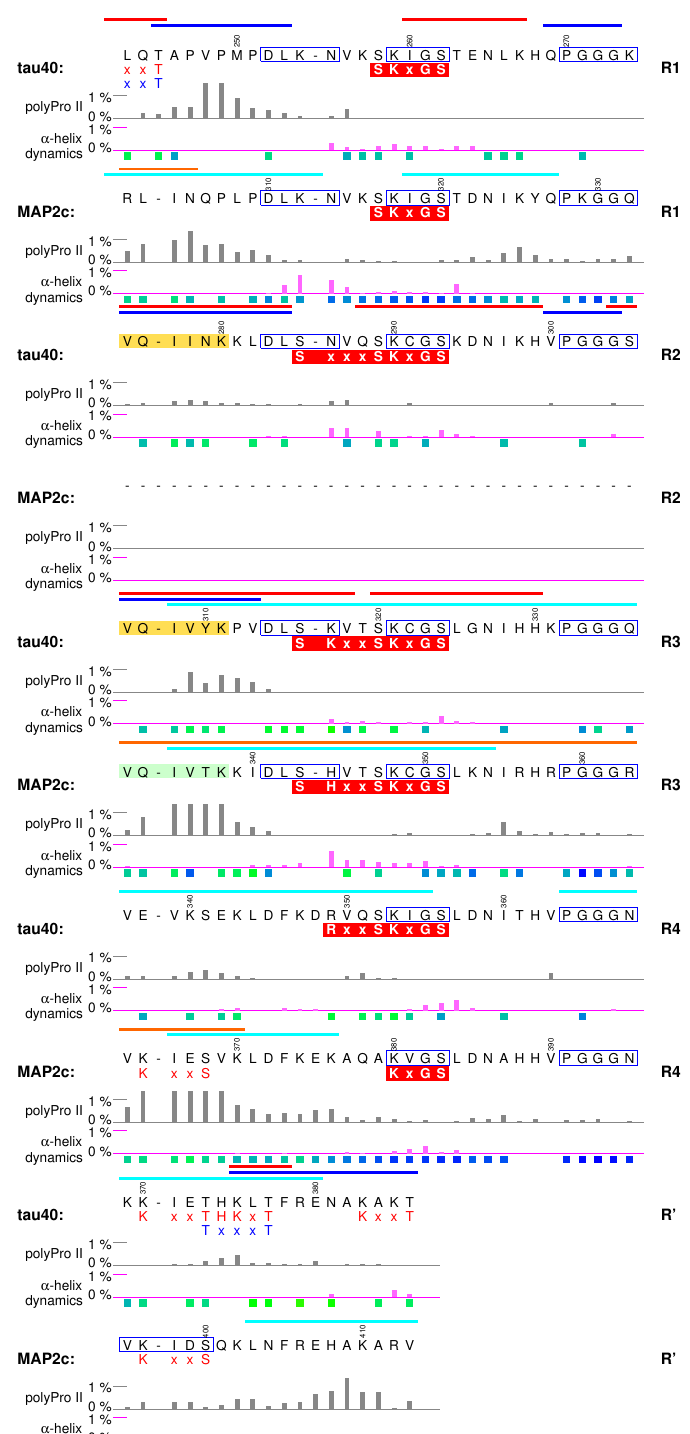
Figure 6. MTBDs of human tau40 and rat MAP2c. MTBRs 1–4 are labeled R1–R4, respectively, the following sequence homologous with the N-terminal sequence of MTBRs is labeled R (cid:48) . Aggregation sites of tau40 are shown in yellow boxes and the corresponding sequence of MAP2c is shown in a pale green box. Complex phosphorylation sites including the MARK recognition motifs are shown in red boxes. Regions of tau interacting with filamentous actin are indicated by the horizontal red bars above the sequence. Other symbols are used as described for Figures 3 and